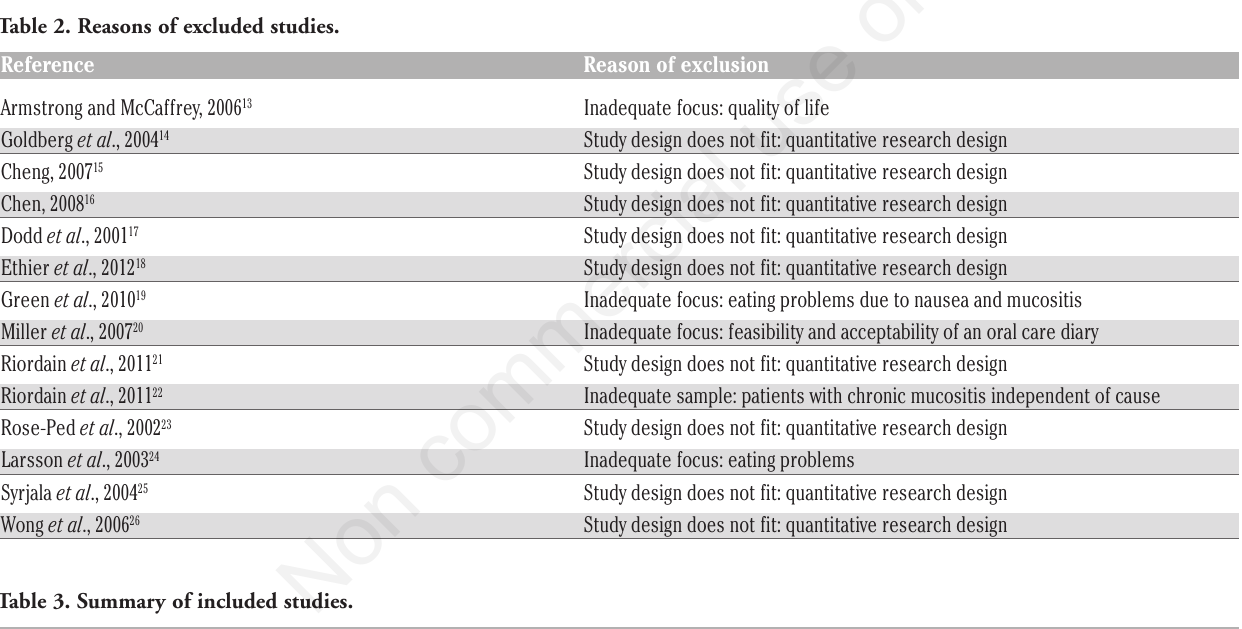
Table 2. Reasons of excluded